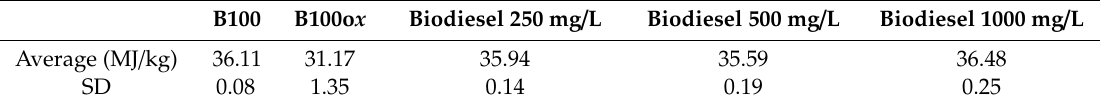
Table 4. Higher heating value of biodiesel before and after active oxygen method.